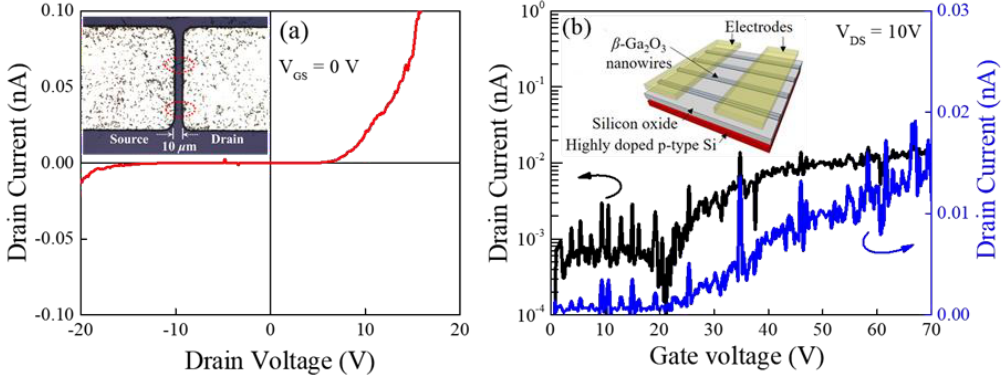
Figure 6. ( a ) output (I DS -V DS ) and ( b ) transfer (I DS -V GS ) characteristics of the Ga 2 O 3 nanorod FETs. Inset image of ( a ): optical microscope image of β -Ga 2 O 3 FET (source-drain distance: 10 μm). Inset image of ( b ): a schematic drawing of the bird’s eye view of the Ga 2 O 3 FET. This limited current density the Ga 2 O 3 nanorod FETs was comparable to the semi-insulating Ga 2 O 3 bulk FETs without source and drain doping [51].